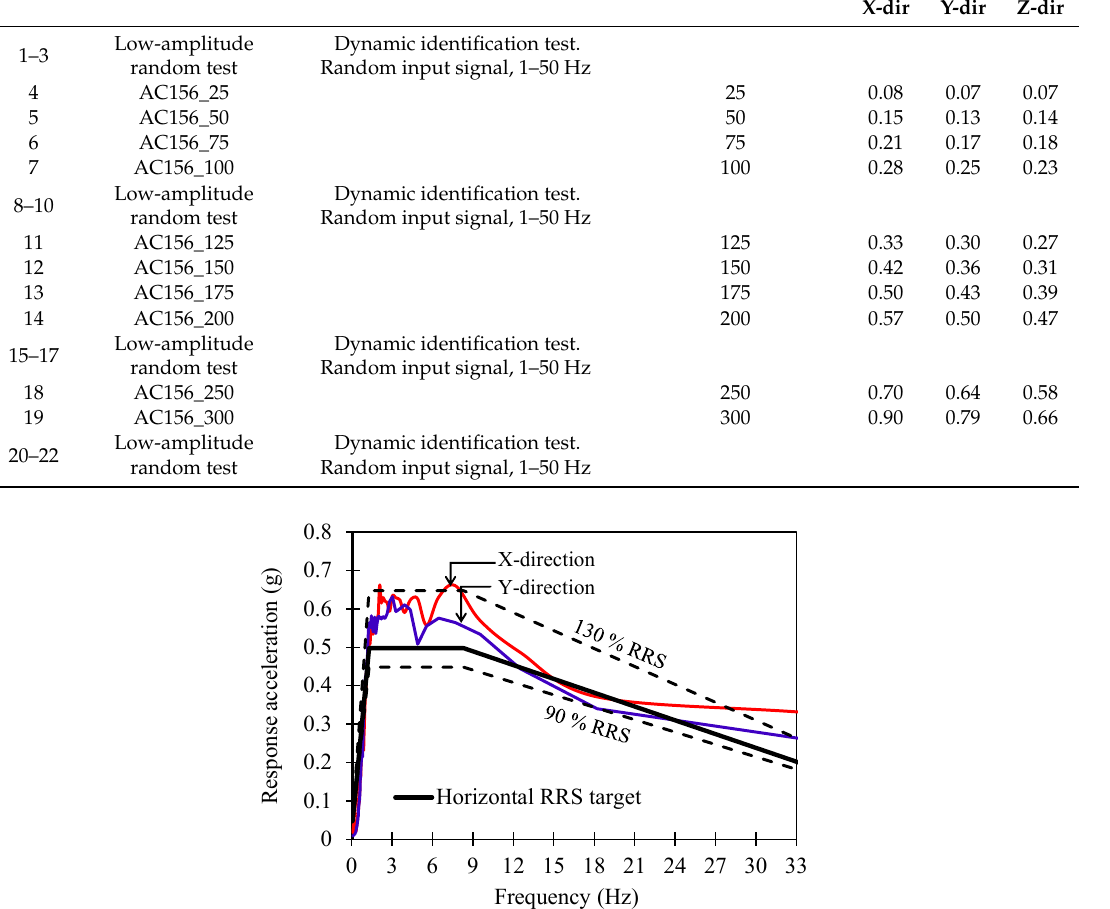
Table 3. Input and test protocol. PGA, peak ground acceleration.